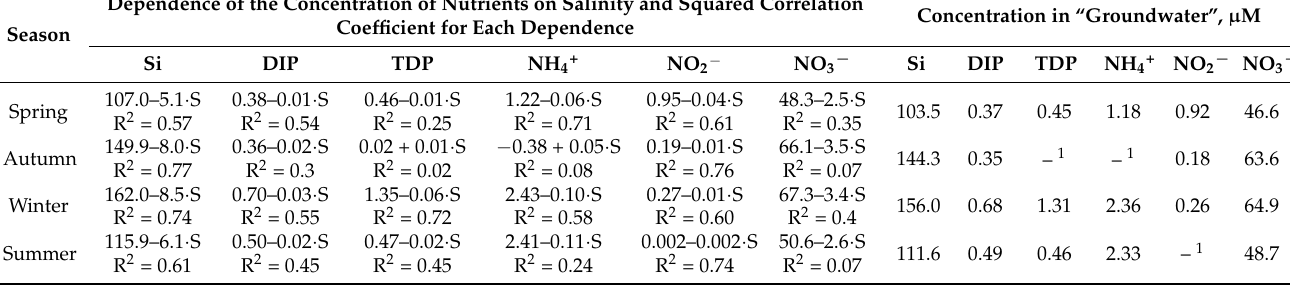
Table 3. Seasonal variability of the dependences of nutrient concentrations in the surface layer on salinity and concentrations of nutrients in the